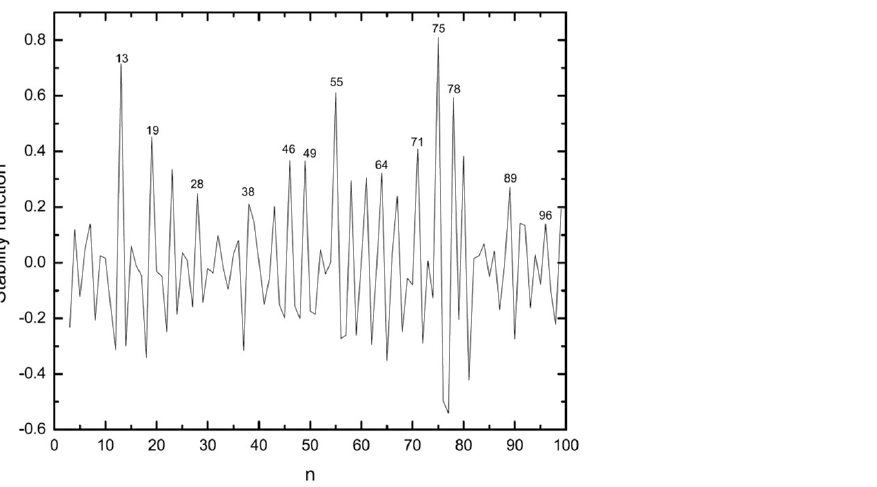
Figure 6. The stability function (in eV) of the silver clusters versus cluster size calculated using EAM-BH.